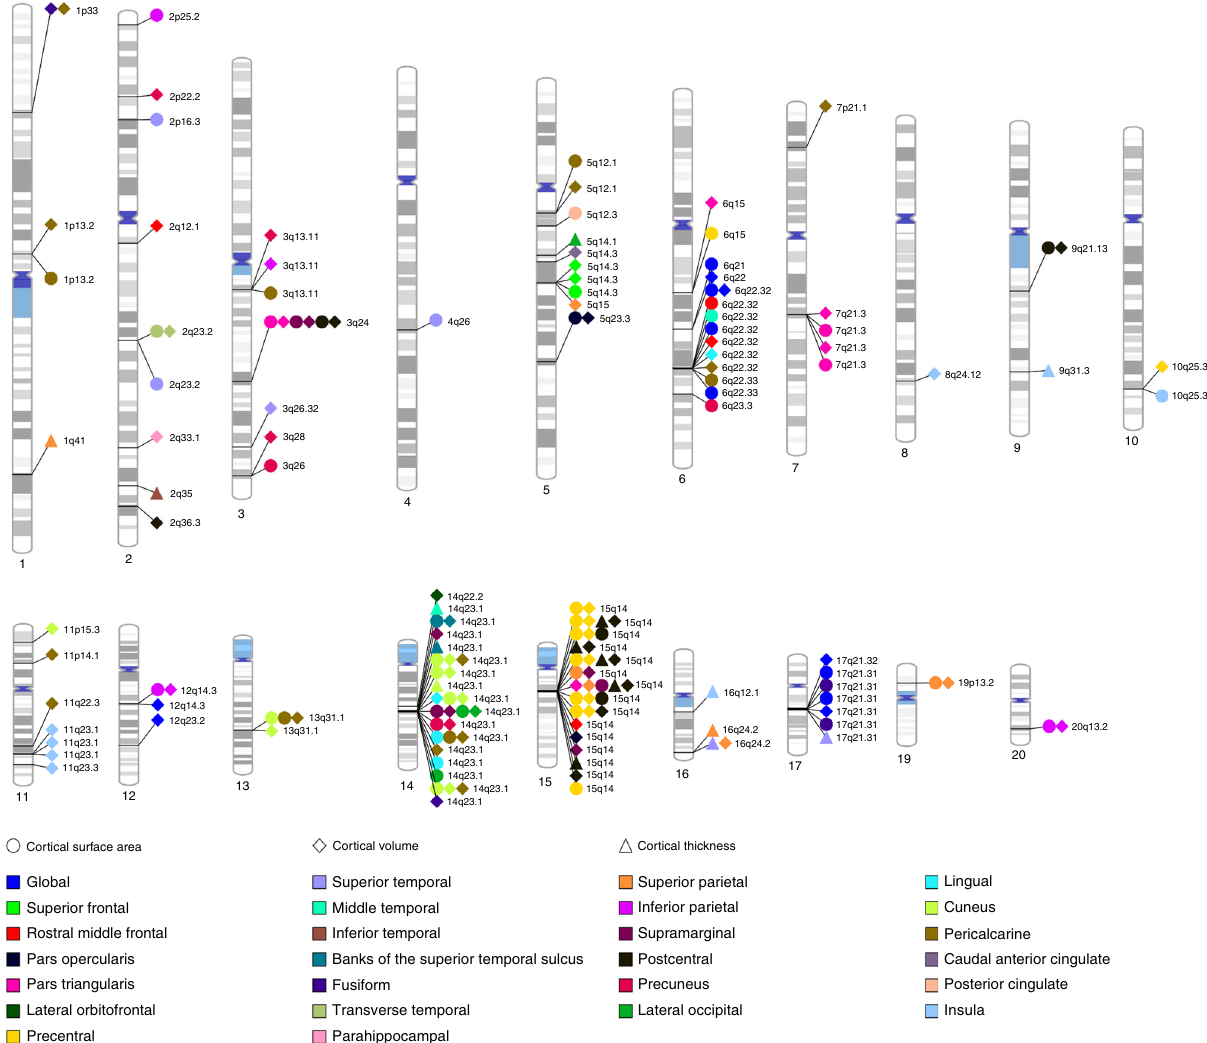
Fig. 1 Chromosomal ideogram of genome-wide signi fi cant associations with measures of cortical structure. Cortical surface areas, cortical volumes and cortical thickness. Each point represents the signi fi cantly associated variant, the colors correspond to the different cortical regions and the shape to different type of measument ( p Discovery < 1.09 × 10 − 9